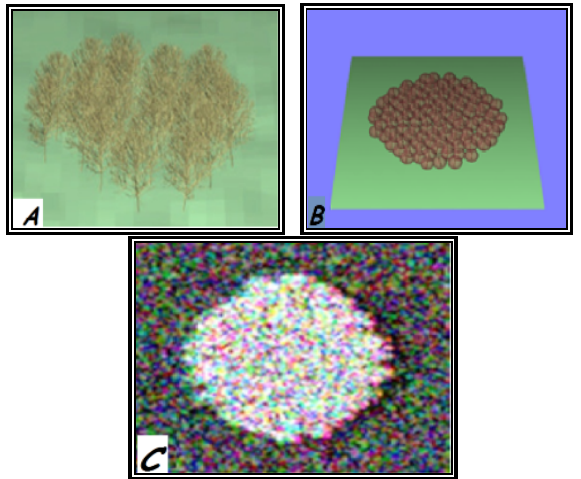
Fig.1. Forest species (A), plot density (B), Pauli RGB image